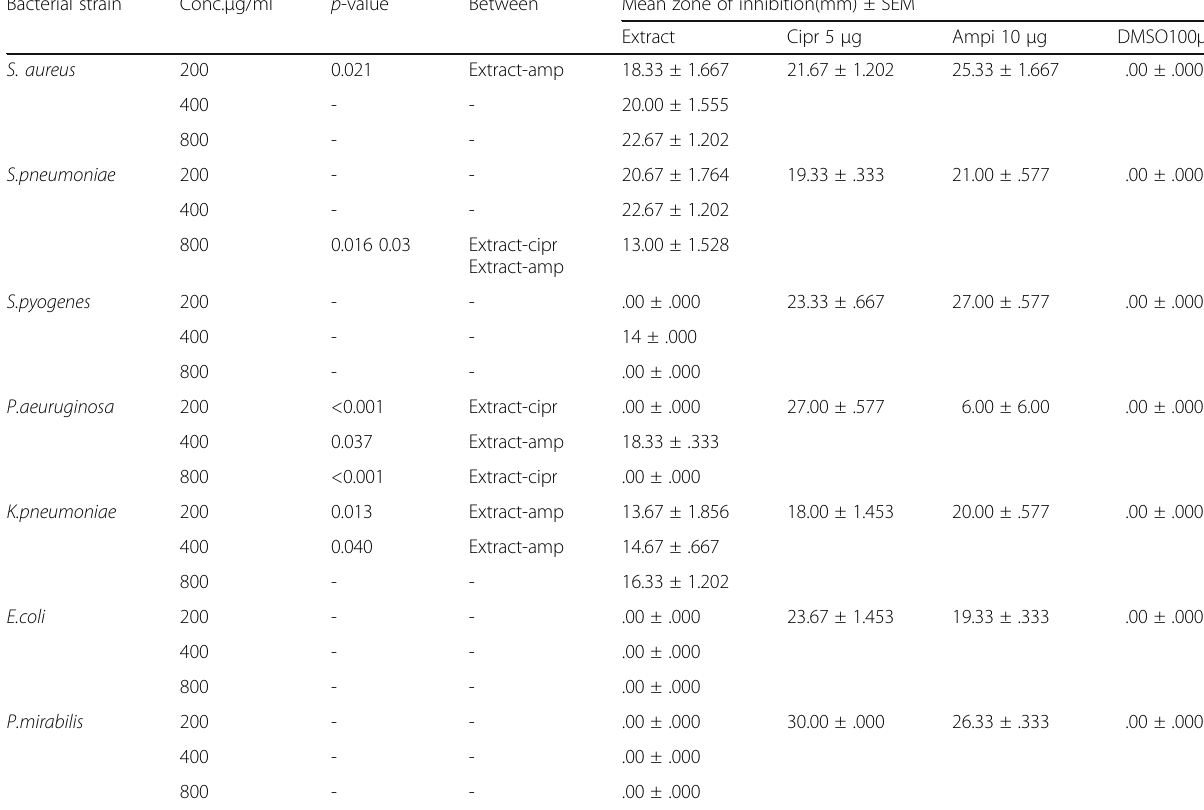
Table 2 Diameter of zone of inhibition (mm) against bacteria by H.micranthus leaves extract Bacterial strain